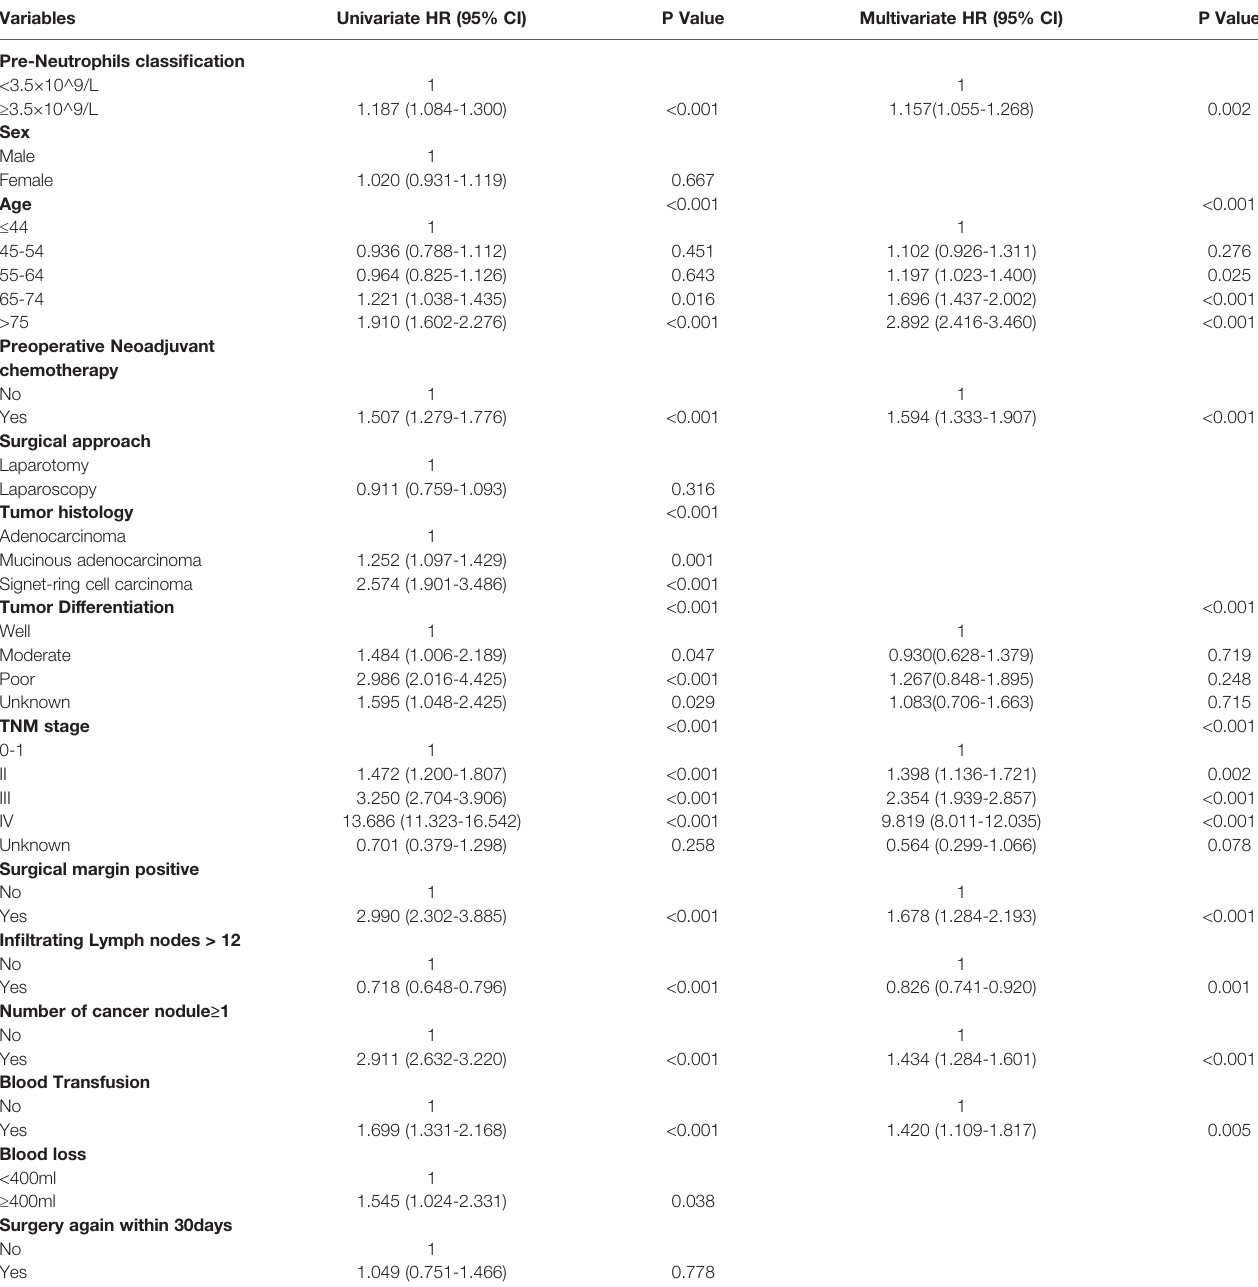
TABLE 7 | Univariate and multivariate Cox regression analysis for OS in the propensity-matched